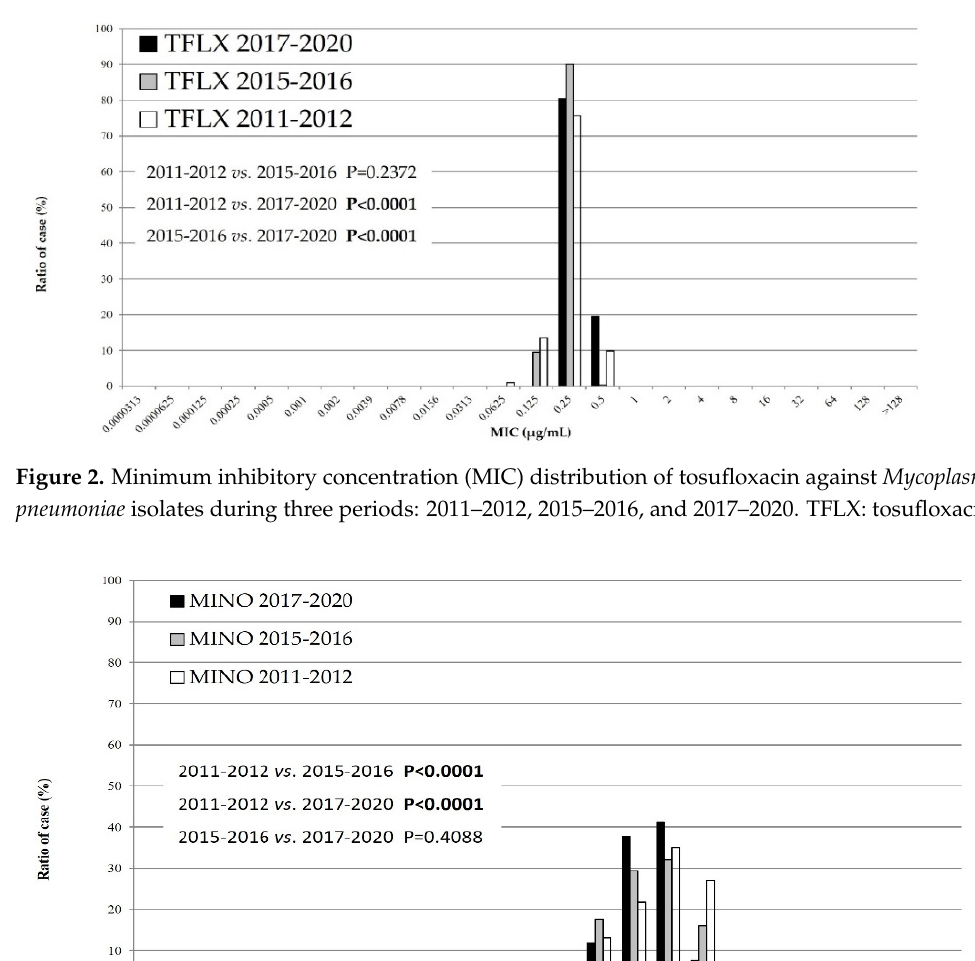
Figure 2. Minimum inhibitory concentration (MIC) distribution of tosufloxacin against Mycoplasma